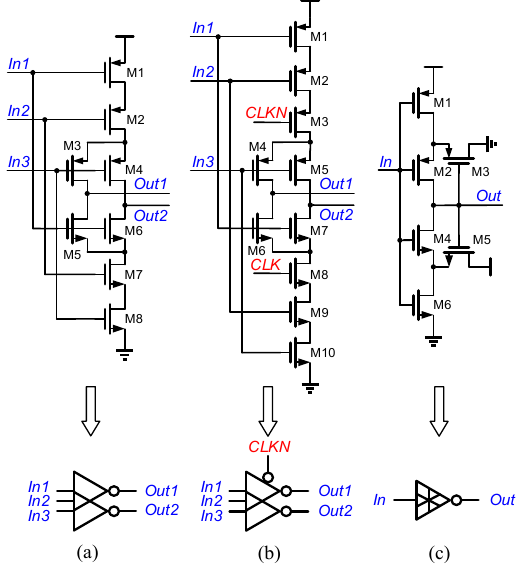
Figure 3c. The structure determines the inversion threshold and forms a hysteresis win- can filter the glitch of an input signal.